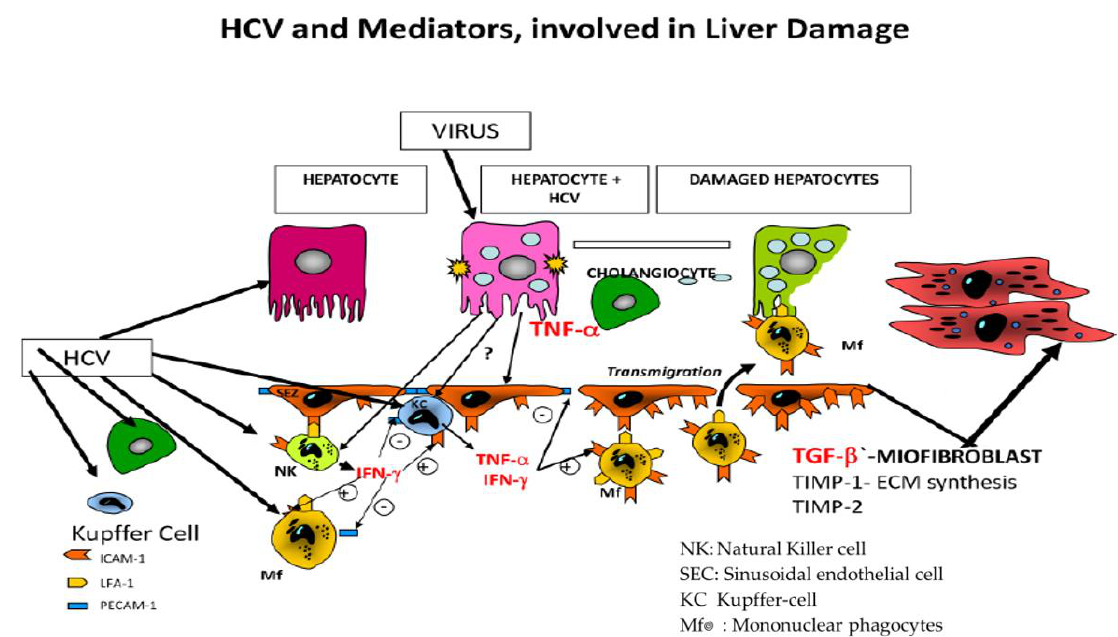
Figure 1. Hepatocytes, sinusoidal epithelial cells (SEC), macrophages [(Kupffer cells (KC)] and stellate cells are the main cells Figure 1- The populations of the liver consist of parenchimal cells (hepatocytes), sinusoidal epithelial in the liver. Transformations of stellate cells into myofibroblasts is influenced by the following proinflammatory cytokines: interferon alpha and gamma (IFN- α ; IFN γ ). TNF α , and vascular endothelial growth factor (VEGF). Tissue inhibitors of cells (SEC), macrophages - Kupffer cells (KC) and stellate cells. Transformations of stellate cells into metalloproteinases (TIMP 1 and 2) and transforming growth factor (TGF − β ) contribute to modulating liver myofibroblasts is influenced by proinflammatory cytokines: interferon-alpha and gamma (IFN-  ; IFNγ). TNF α, and vascular endothelial growth factor (VEGF).Tissue inhibitors of metalloproteinases (TIMP 1 and 2) and transforming growth factor (TGF − ), contribute to modulate liver fibrosis.